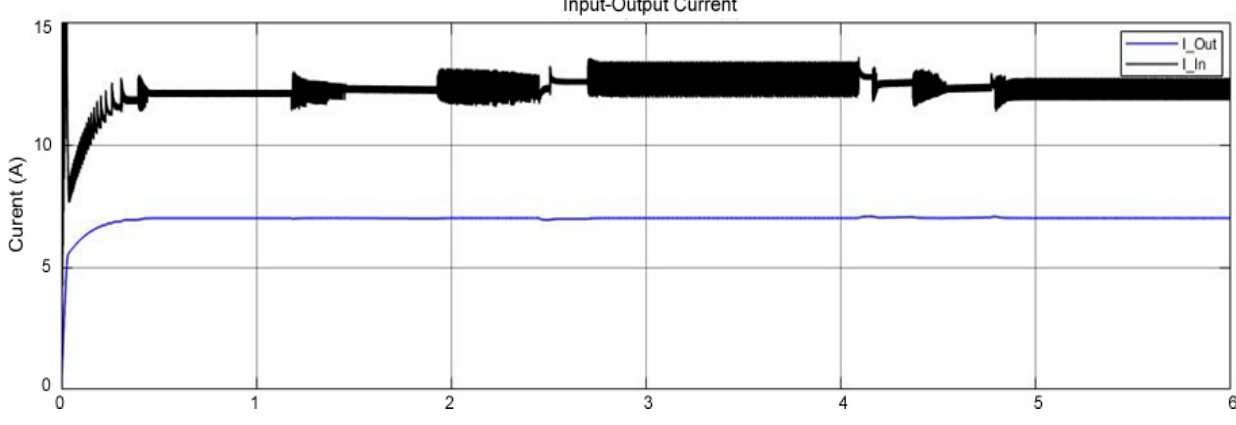
Figure 8. Input and output currents of two − phase IBC with EKF MPPT.